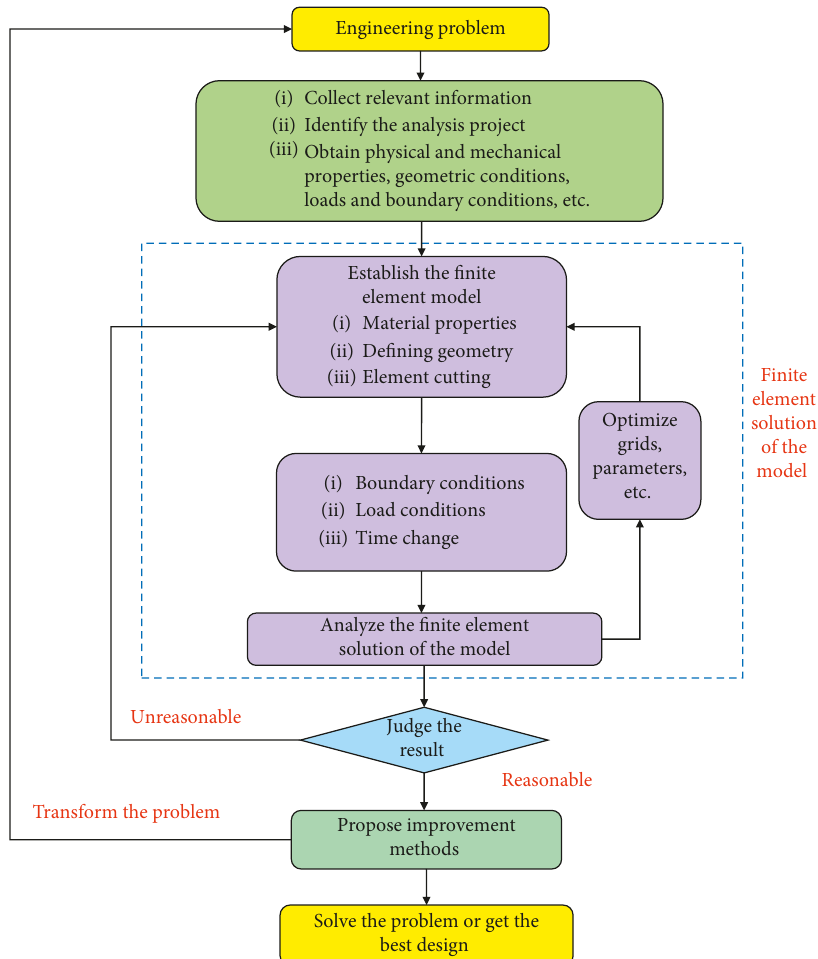
Figure 2: The basic process of FEM (revised from